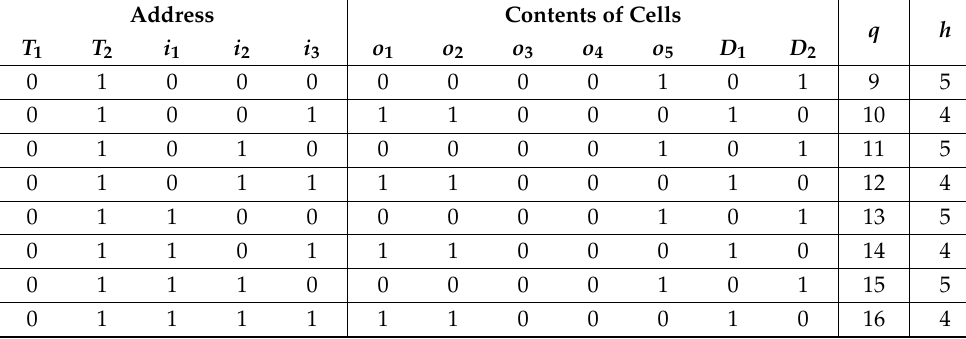
Table 9. Part of truth table for FSM A 1